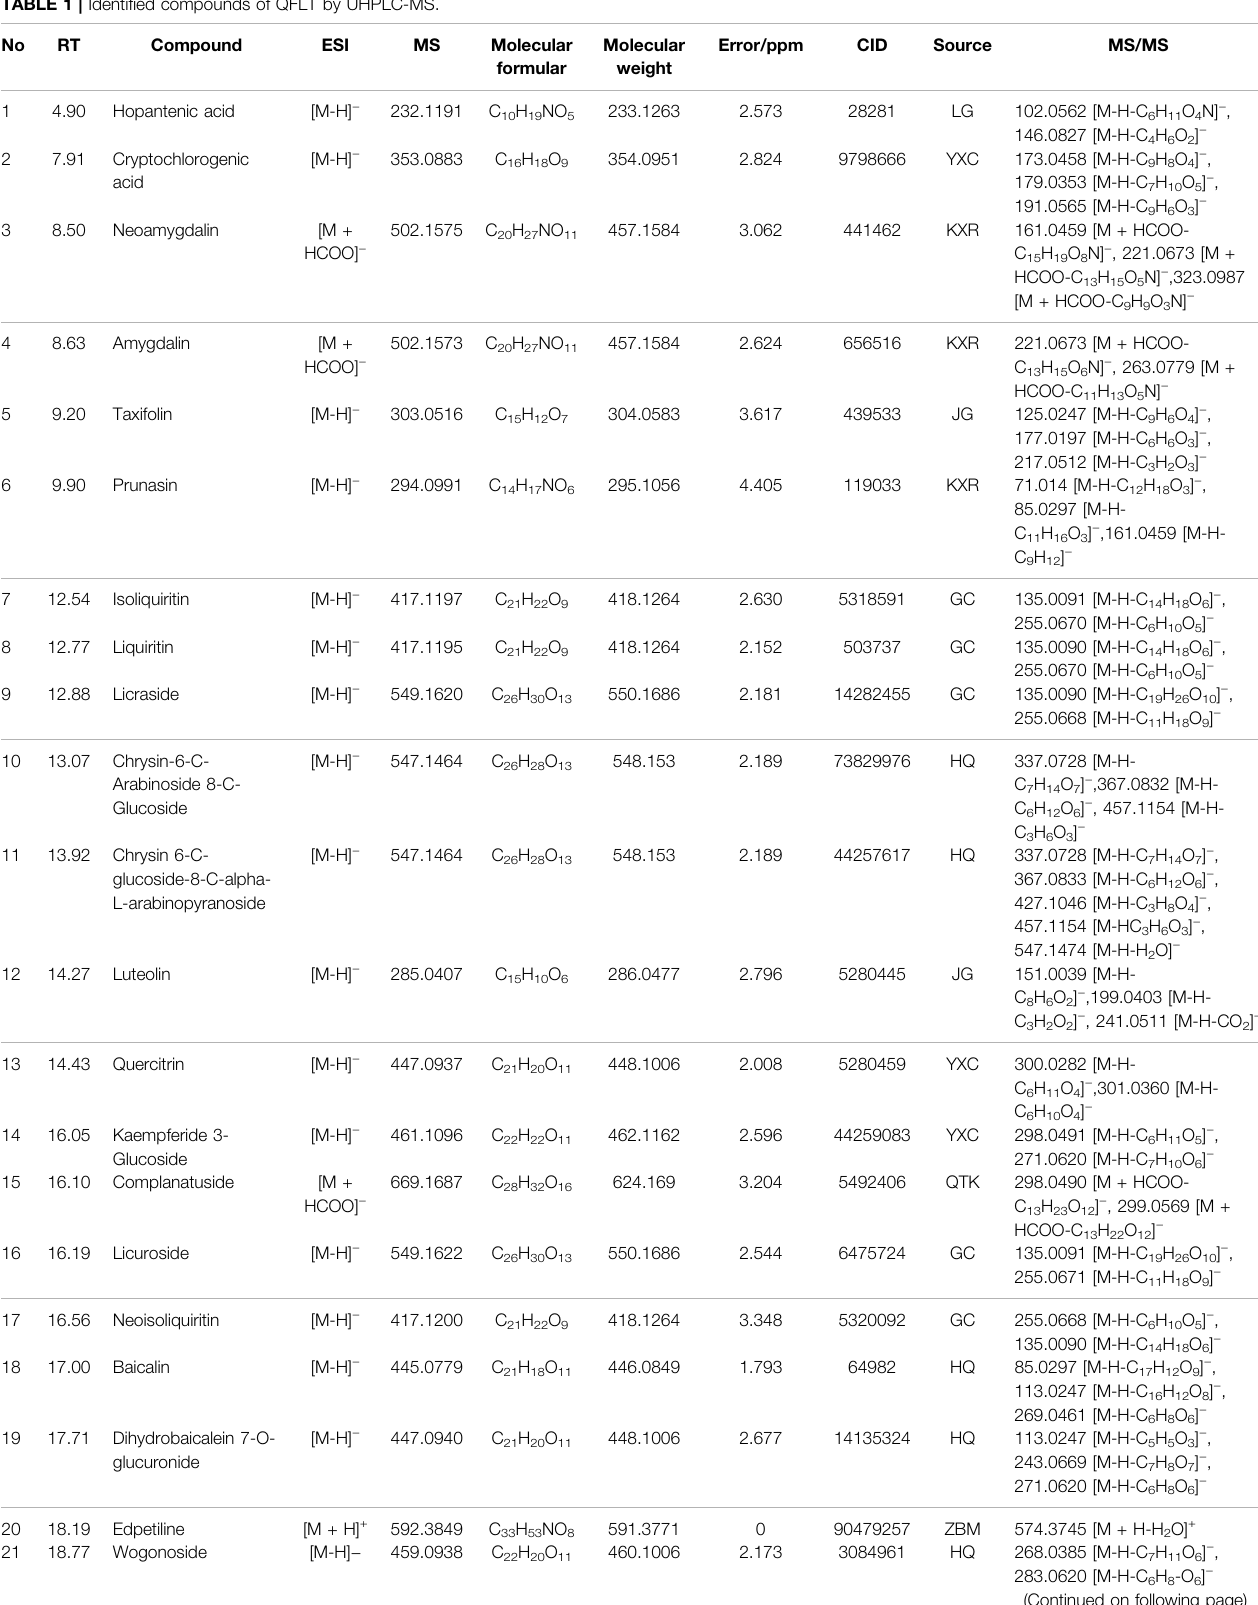
TABLE 1 | Identi fi ed compounds of QFLT by